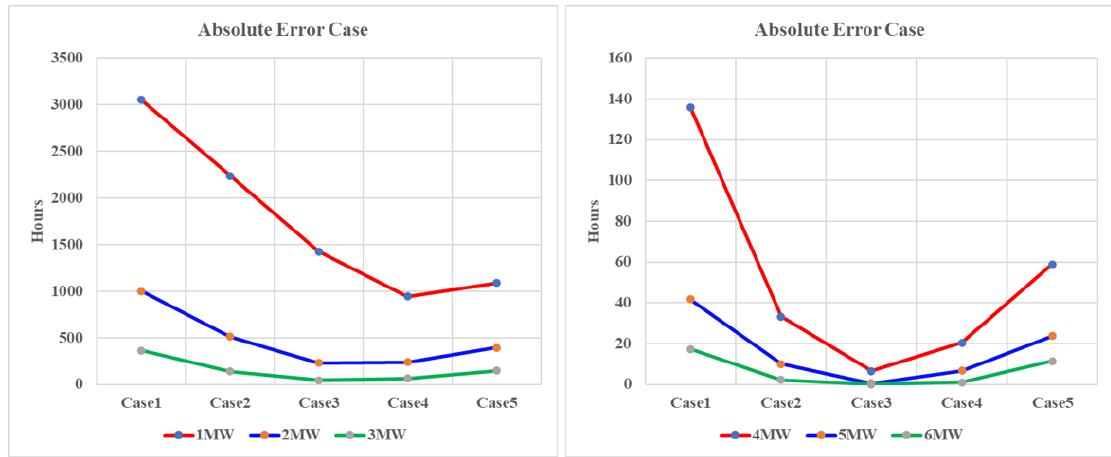
Figure 6. Cumulative hours of forecast error for each case in Table 1.